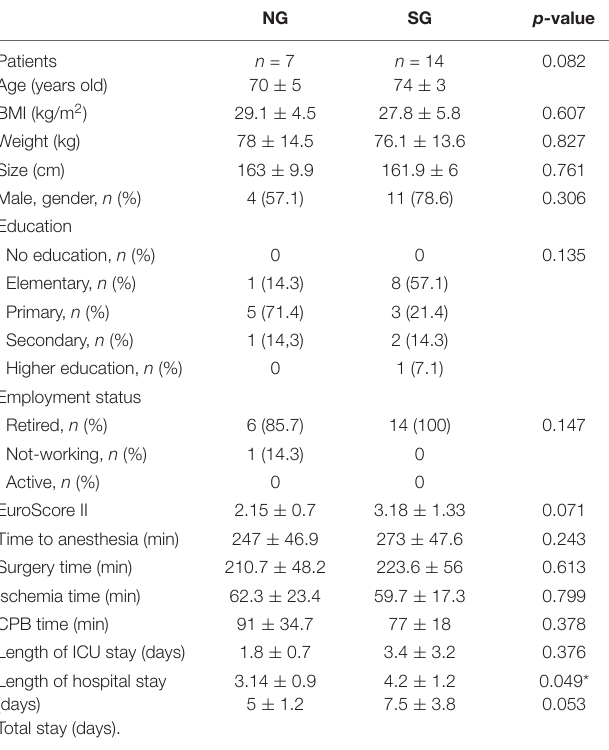
TABLE 2 | Physiological domain in the Postoperative Quality Recovery Scale